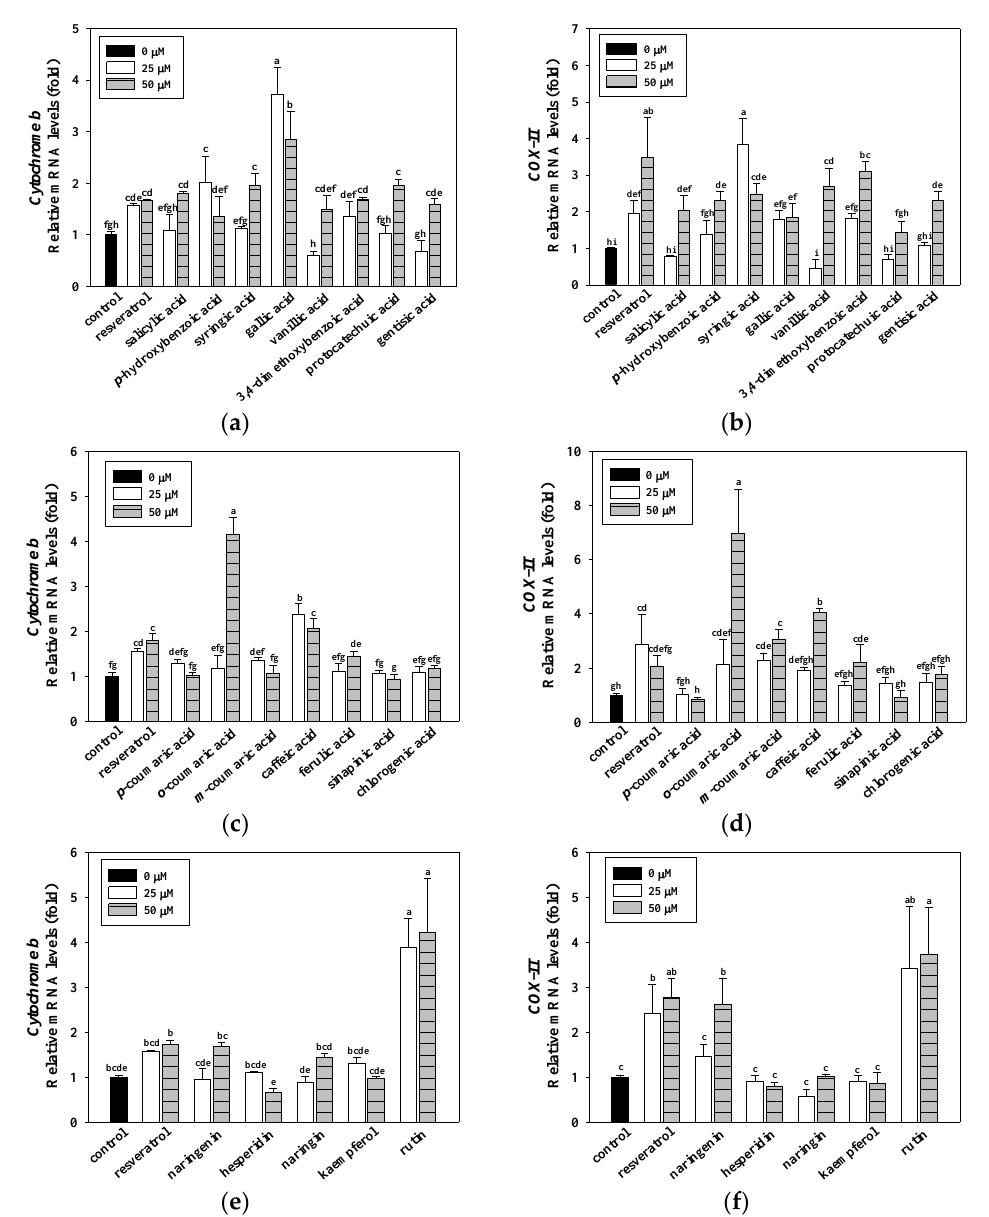
Figure 2. Effects of hydroxybenzoic acids ( a , b ), hydroxycinnamic acids ( c , d ), and flavonoids ( e , f ) on mitochondrial gene expressions in C2C12 myotubes. C2C12 myotubes were incubated with 25 and 50 µ M of resveratrol and hydroxybenzoic acids for 24 h. Resveratrol was used as positive control. Control means C2C12 myotubes at 0.1% DMSO was used as a solvent control. The reported values are the means ± SD ( n = 3). Mean values with different letters were significantly different ( p < 0.05).